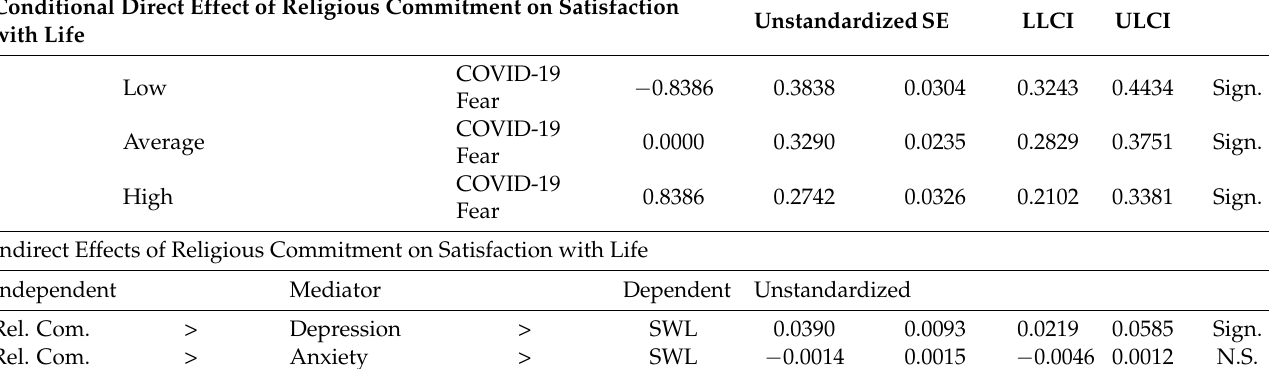
Table 5. Conditional direct and indirect effects of religious commitment on satisfaction with